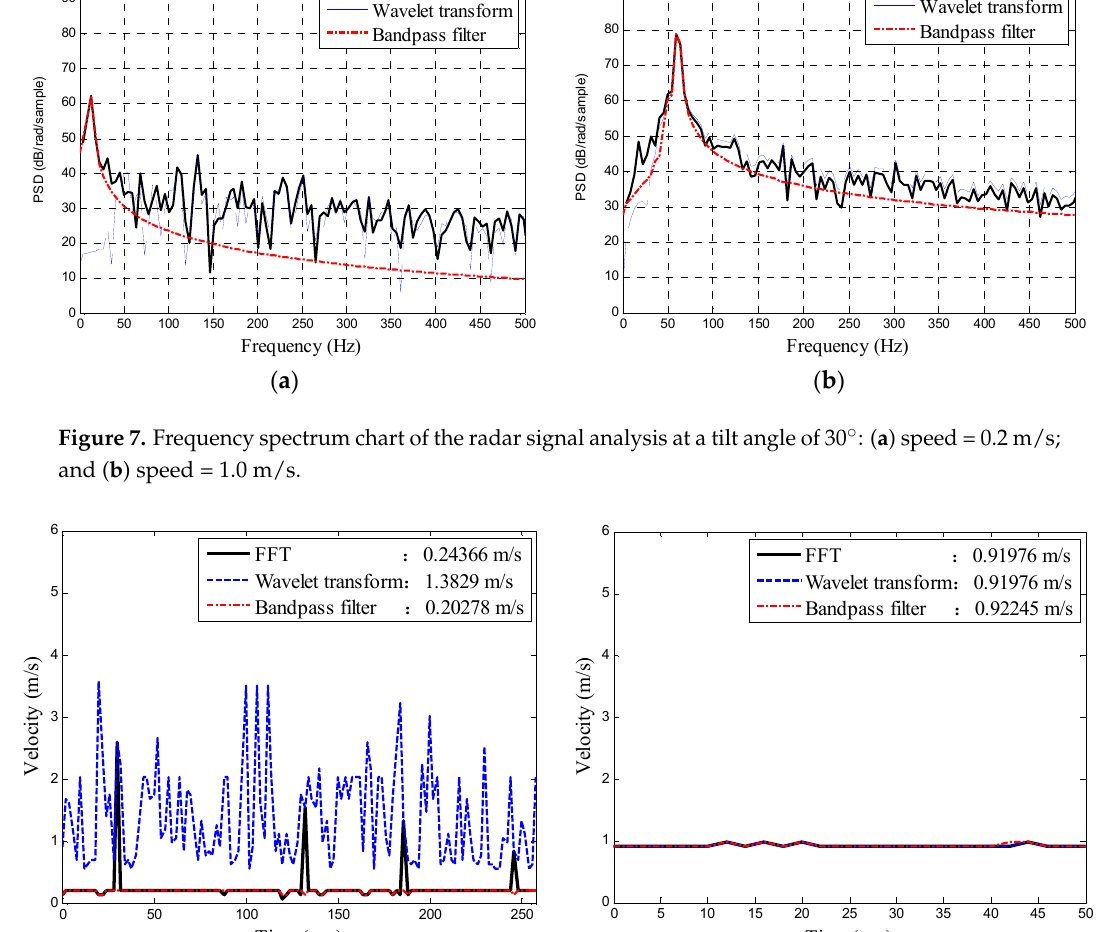
Figure 6. Charts of the original signals of radar waves at a tilt angle of 30°: ( a ) speed = 0.2 m/s; and ( b ) speed = 1.0 m/s.